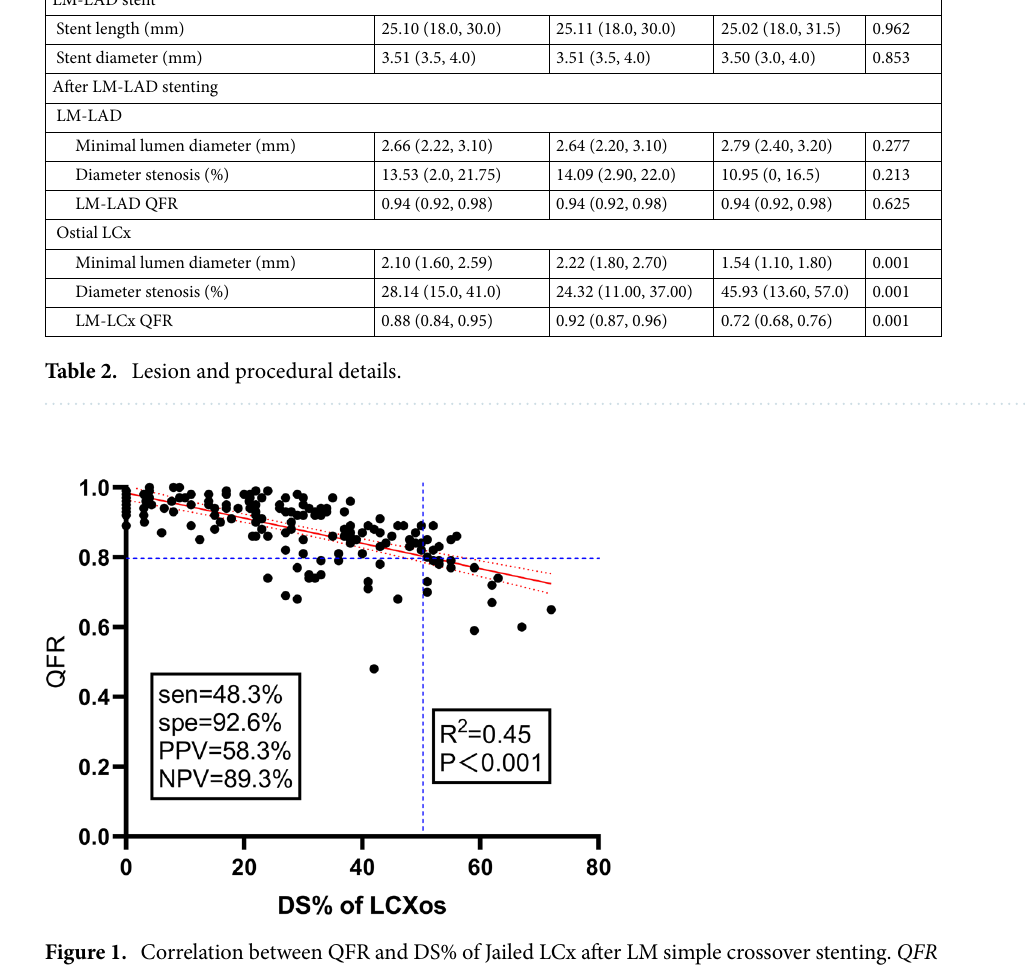
Figure 1. Correlation between QFR and DS% of Jailed LCx after LM simple crossover stenting. QFR quantitative flow reserve, DS% percentage of diameter stenosis, Sen sensitivity, Spe specificity, NPV negative predictive value, PPV positive predictive value, LCXos the ostium of left circumflex coronary artery, LM left main coronary